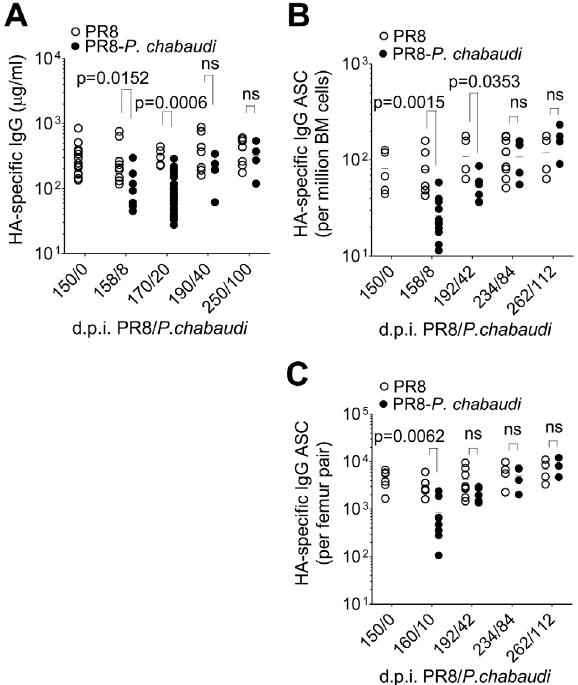
Figure 5. Return of HA-specific IgG and HA-specific IgG ASC to bone marrow at late time points after P.chabaudi infection. 150 days after PR8 infection, mice were infected with P. chabaudi , A. HA- specific IgG quantified by ELISA in PR8- P. chabaudi -infected mice [( n=9(d150/0), 5(d158/8), 5(d170/20), 8(d190/40) and 7(d250/100)] and PR8-only controls [( # ); n=9(d150/0), 8(d158/8), 30(d170/20), 4(d190/40) and 4(d250/100)]. B and C. HA-specific IgG antibody-secreting cells (ASCs) in bone marrow from femur pairs of in PR8- P. chabaudi -infected N ) and PR8-only controls ( # ) [PR8- P. chabaudi n=5(d150/0), mice ( 12(d158/8), 6(d192/42), 4(d234/84) and 4(262/112); PR8 only 5(d150/0), 7(d158/8), 5(d192/42), 8(d234/84) and 4(262/112)]. The data were pooled from 2 independent experiments and expressed B , per million bone marrow cells or C , per femur pair. In figures A–C , error bars indicate the median 6 S.E. and statistical values were calculated using a two-tailed Mann-Whitney test. Non-significant values (P . 0.05) are not indicated on the